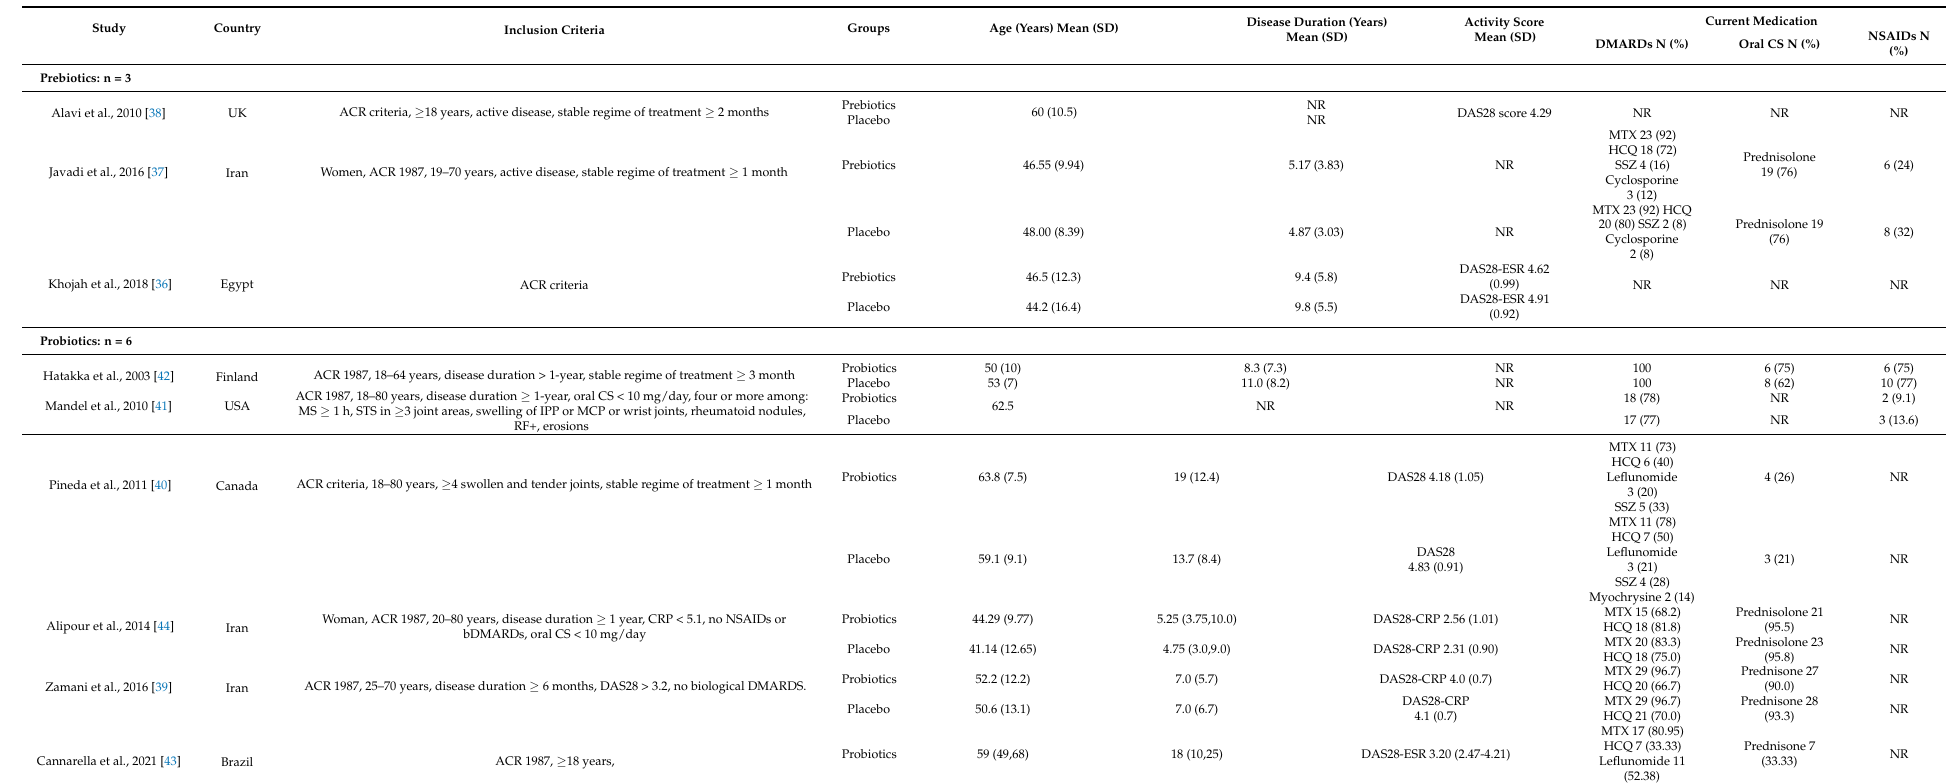
Table 1. Baseline characteristics of patients included in the